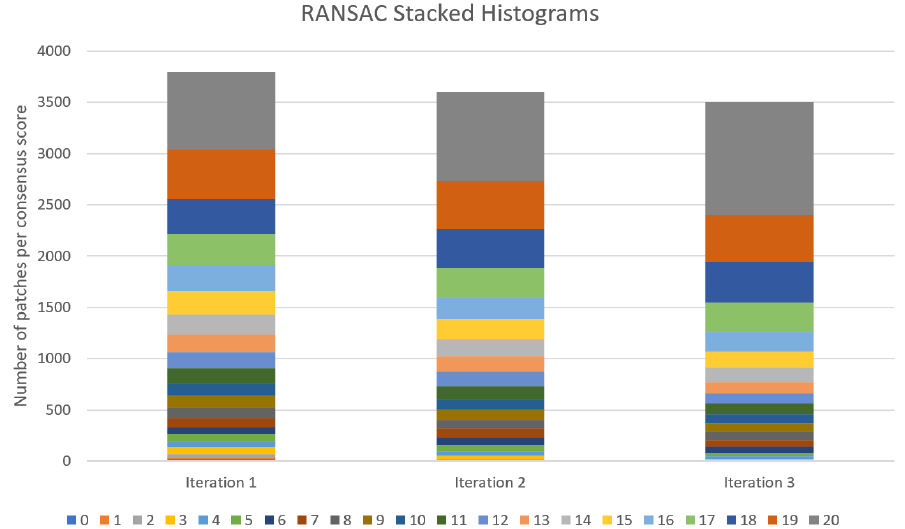
Figure 6. Three iterations of RANSAC histograms training GS3 vs. GS4 DL models.